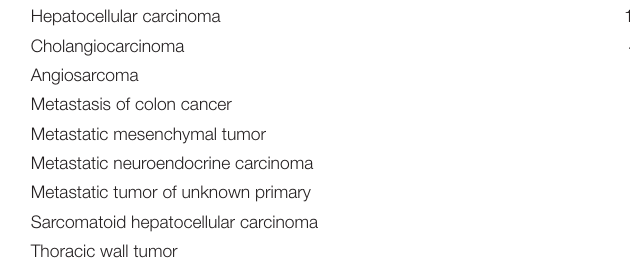
TABLE 2 | The final diagnoses of the